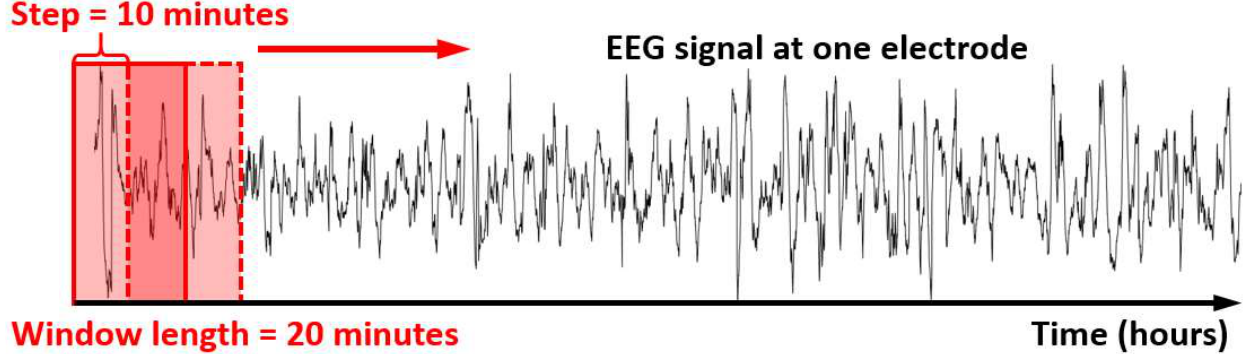
Figure 1. Demonstration of the sliding window EEG quantification of dynamic tPAC m using 20 min window size and EEG data at P3 electrode as an example. The solid red box denotes the first 20 min window used to calculate the first tPAC m index. The dashed box denotes the next sliding-window selection of EEG signals based on a 10 min step (50% of the window length), which is used to calculate the second tPAC m index. The window moves across the total length of EEG signal till the end, producing a series of tPAC m indexes time-dependently. EEG: Electroencephalogram.